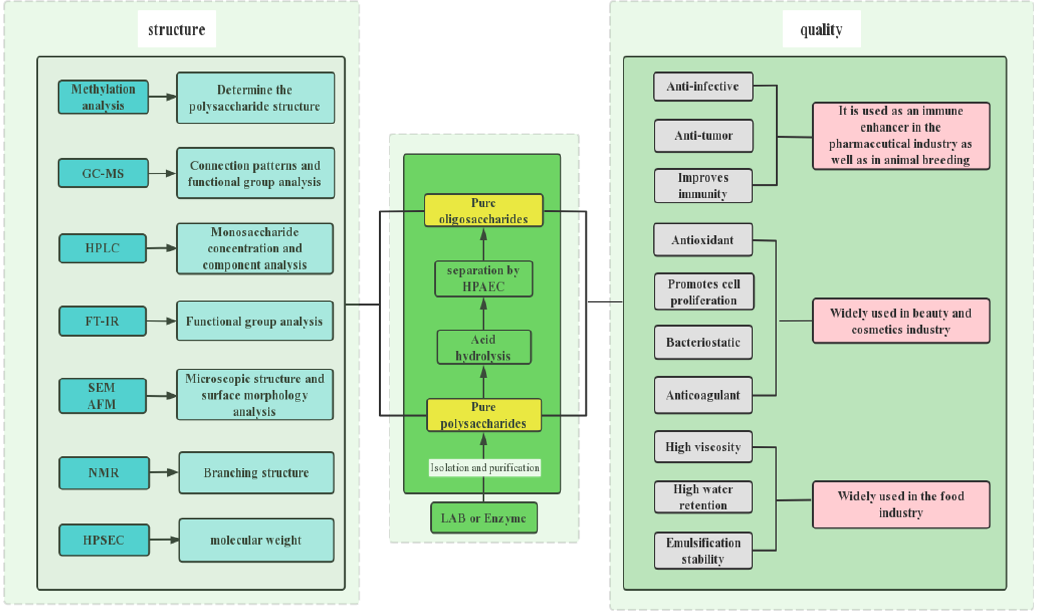
Figure 6. Common detection methods of EPSs , as well as the related properties of